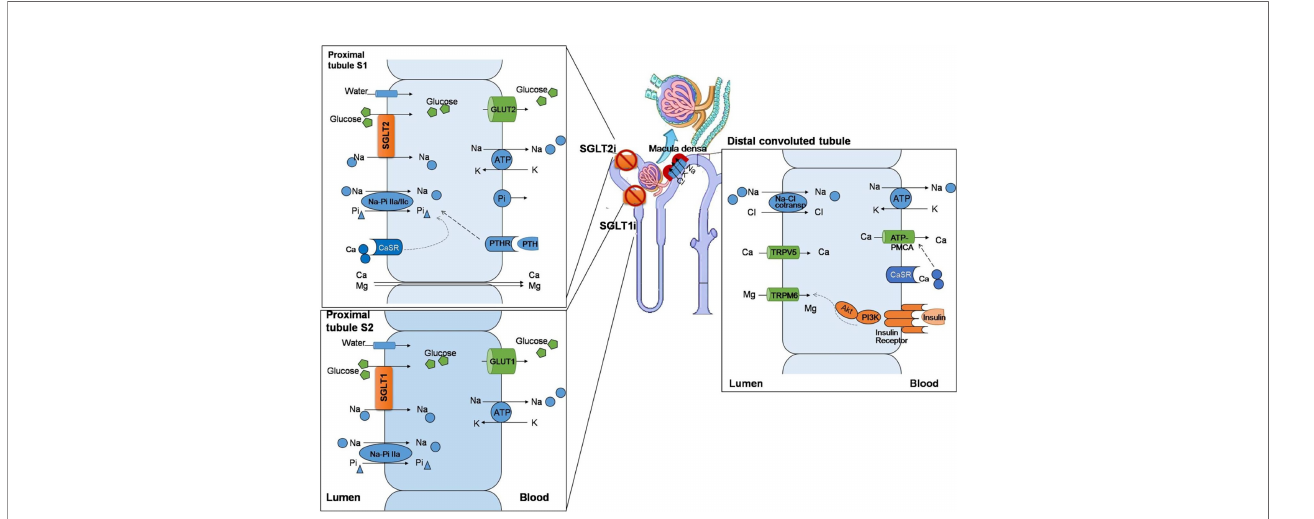
FIGURE 1 | The effect of sodium – glucose co-transporters (SGLTs) on the regulation of mineral ions in renal tubules. The SGLT-1/SGLT-2 co-transporters are mainly expressed in proximal renal tubules, regulating the reabsorption of sodium and glucose. SGLT-2 reabsorbs sodium and glucose from the lumen side of proximal tubules and acts synergistically with glucose transporters (GLUTs) to transport glucose into the blood. In addition, the Na – Pi IIa/c co-transporters are expressed in the lumen side, which synergistically regulate the transport of sodium and phosphorus. Calcium and magnesium pass through intercellular channels. In proximal tubules, the calcium-sensing receptor (CaSR) is located on the lumen side, which senses the concentration of extracellular calcium and synergy with the parathyroid hormone receptor (PTHR), which is stimulated by the parathyroid hormone (PTH), to regulate the transporter function and maintain the hemostasis of calcium/ phosphate. Sodium – glucose co-transporter 2 inhibitors (SGLT-2is) increase the excretion of urinary sodium and glucose. The increased sodium delivery in distal convoluted tubules stimulates dense plaques, triggers tubulo-glomerular feedback, and shrinks the afferent glomerular arteriole. In distal convoluted tubules, the insulin receptor is expressed in the blood side. Magnesium reabsorption passes via transient receptor potential melastatin type 6 (TRPM6), and the channel activity is suppressed by insulin binding to the insulin receptor via the PI3K/Akt signaling pathway. In this way, SGLT-1 and SGLT-2 play an important role in regulating mineral